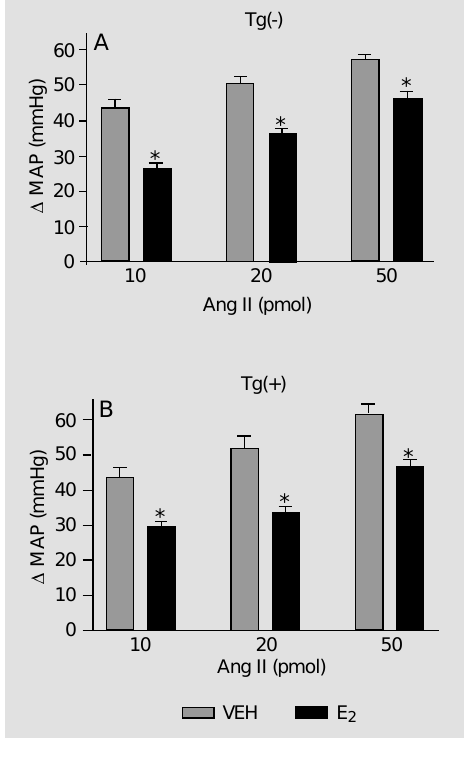
Figure 3 - Effects of 3-week es- trogen (E 2 ) replacement on Ang II pressor responses of con- scious, resting Tg(-) (A) and Tg(+) (B) rats. E 2 attenuates the Ang II-induced pressor responses. Values are reported as mean ± SEM. *P<0.05, VEH vs E 2 (ANOVA). Each group included 6~8 rats. VEH, Vehicle. (Repro- duced from Ref. 62 with permis-